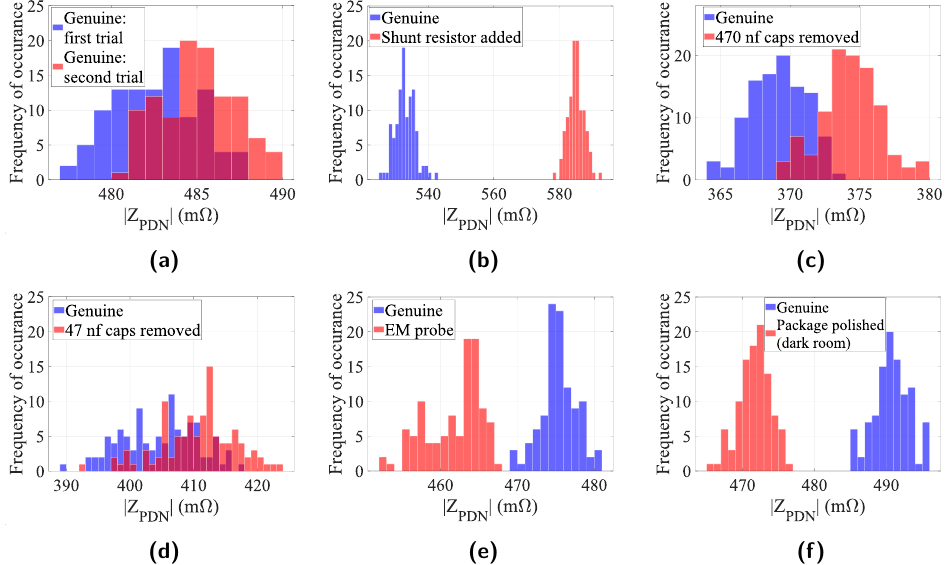
Figure 11: Impedance histogram representations. All histograms are plotted at the frequency point where the distance between the mean of the measurements is maximum. (a) Intra-genuine measurements at f = 315 . 97 MHz. (b) Adding shunt resistor ( f = 587 . 80 MHz). (c) 470 nF capacitors removed ( f = 1 . 57 kHz). (d) 47 nF capacitors removed ( f = 39 . 90 MHz). (e) EM probe on the location showed in Figure. 4(a) in yellow color ( f = 284 . 92 MHz). (f) FPGA package polished (not exposed to light, f = 430 . 96